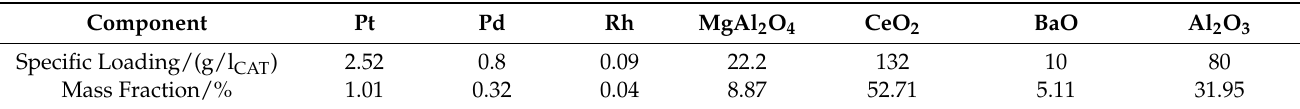
Table 1. Washcoat composition of the LNT